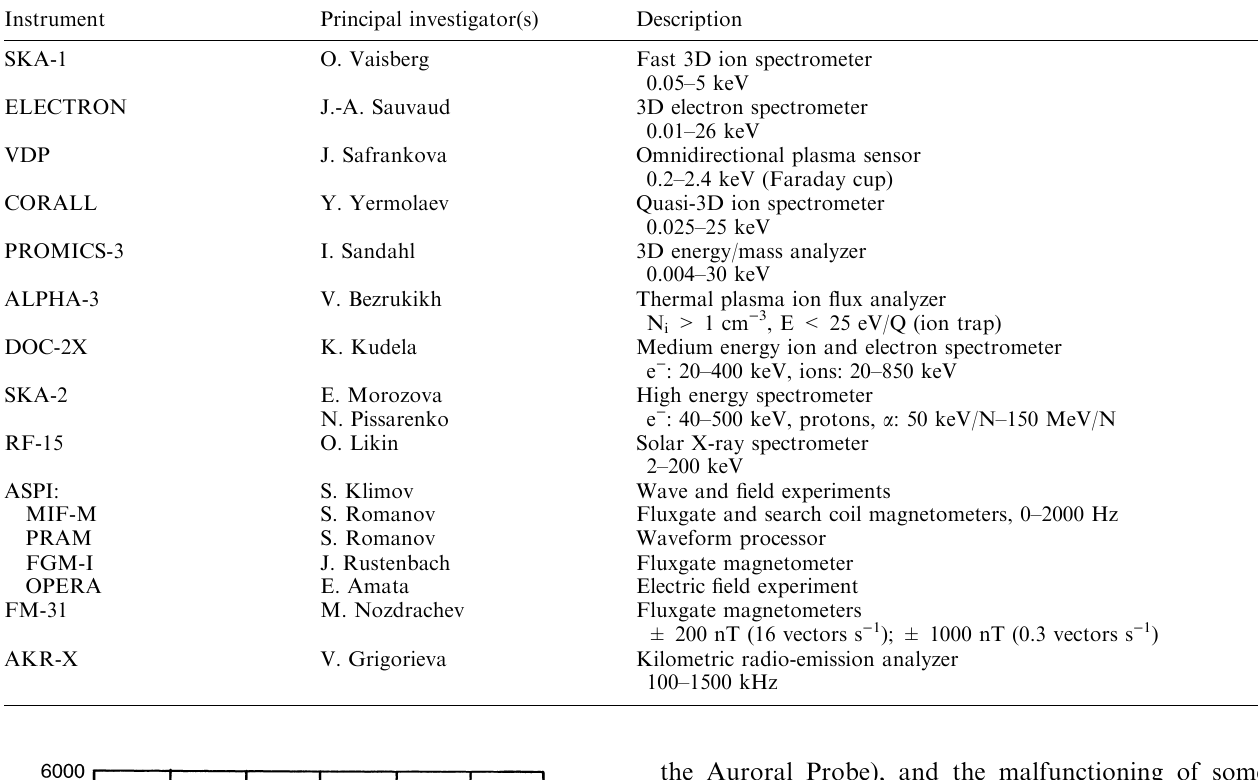
Table 1. List of experiments on the main Interball Tail Probe Instrument